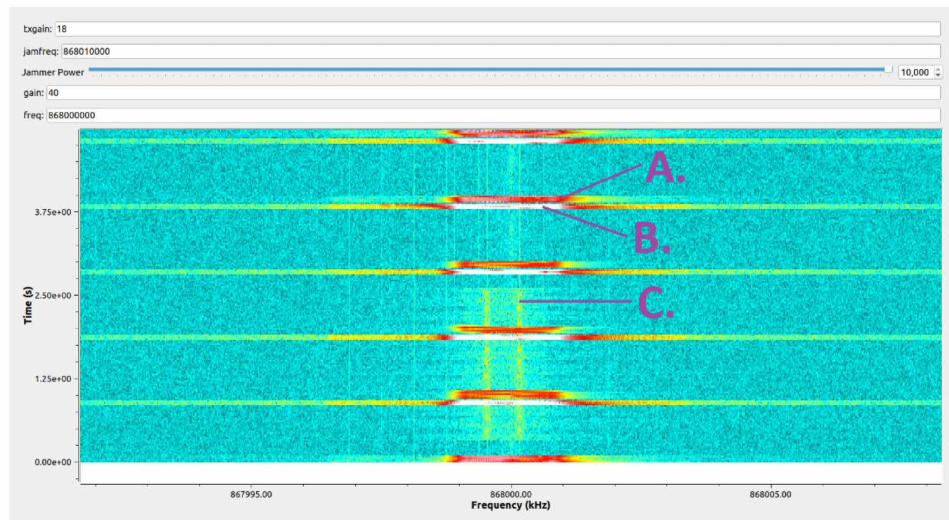
Figure 17. RF spectrum histogram during tests.